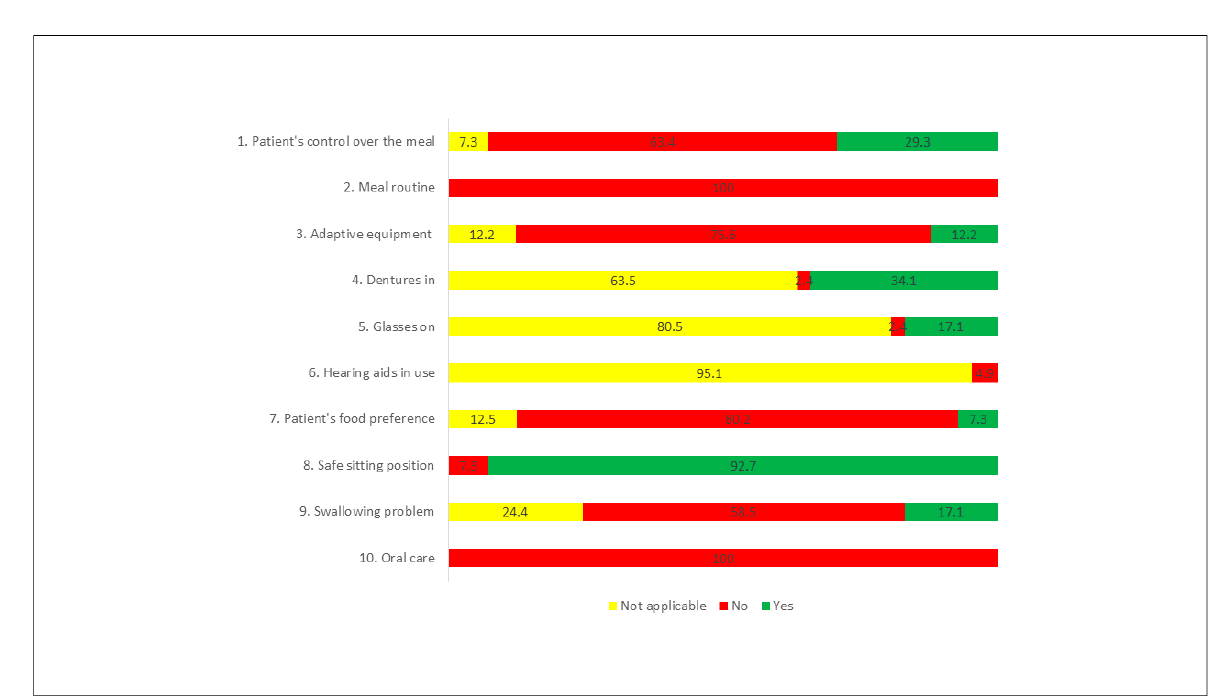
Figure 1. Actions performed (%)—Person with Dementia dimension.